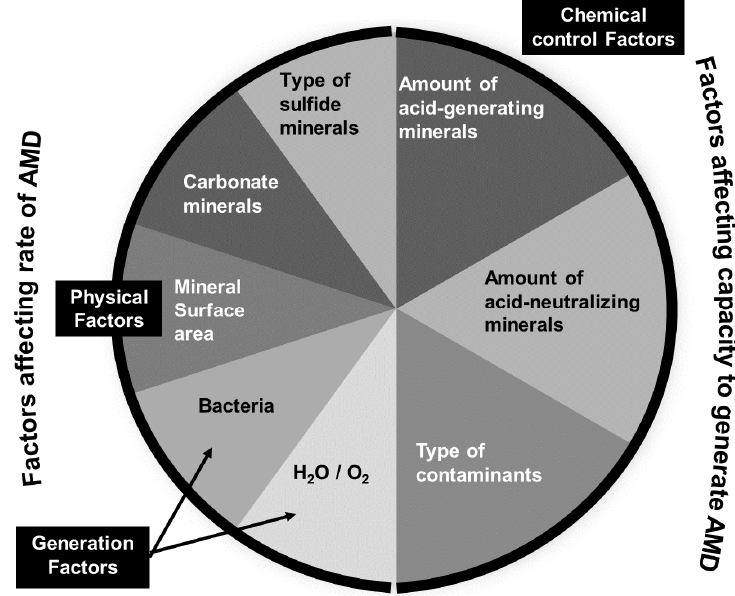
Figure 1. Factors that influence the formation of acid drainage.